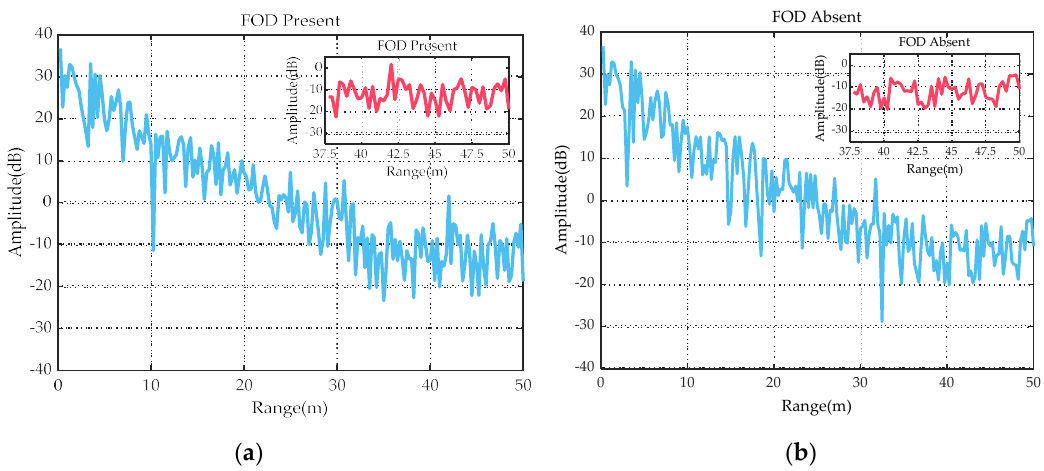
Figure 4. ( a ) Amplitude spectrum with FOD present. (b ) Amplitude spectrum with FOD absent.